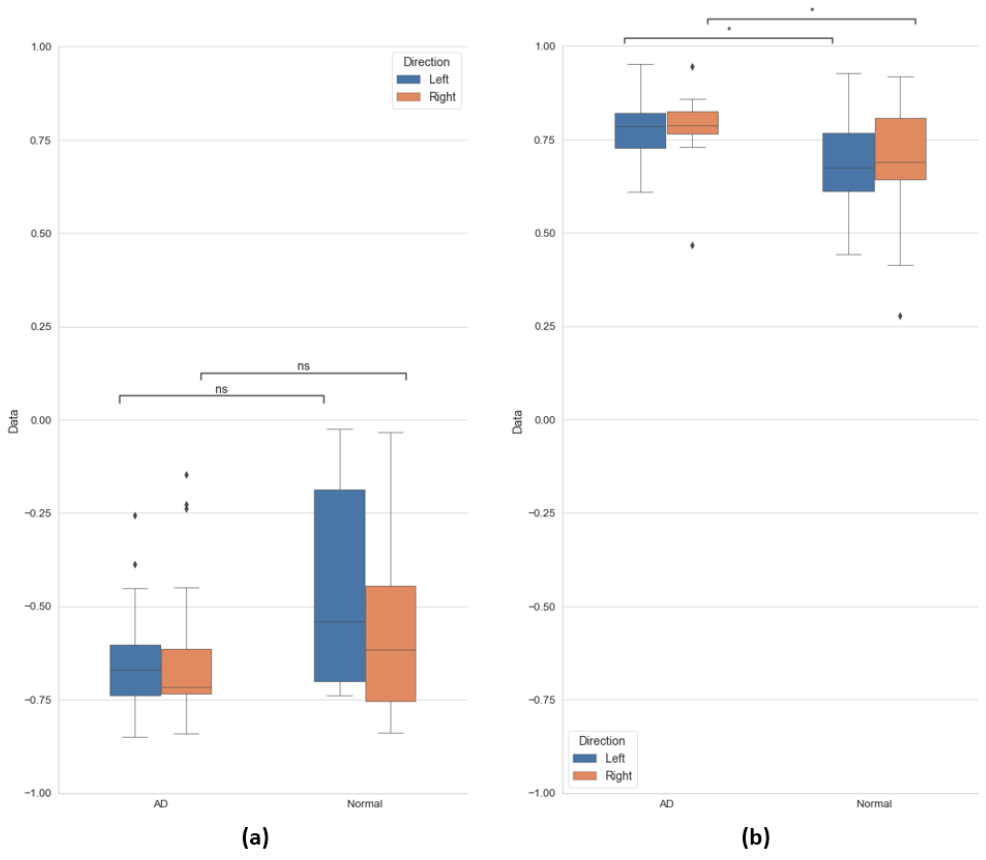
Figure 7. Correlation coe ffi cients represented by the boxplots: ( a ) horizontal and ( b ) vertical.